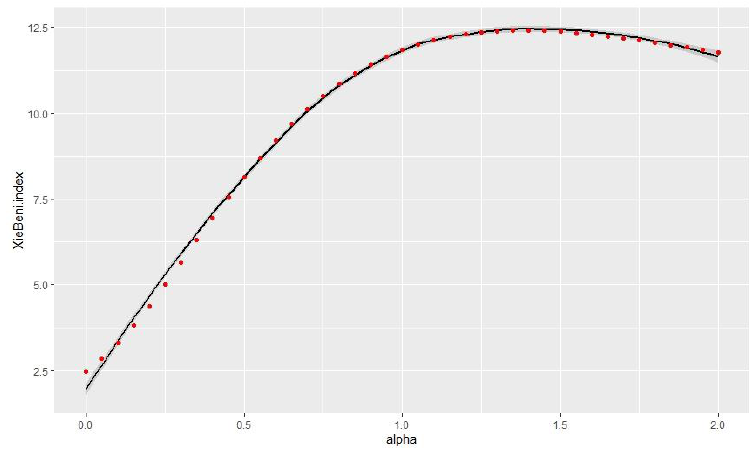
Figure 5. Link between alpha and Xie and Beni index.